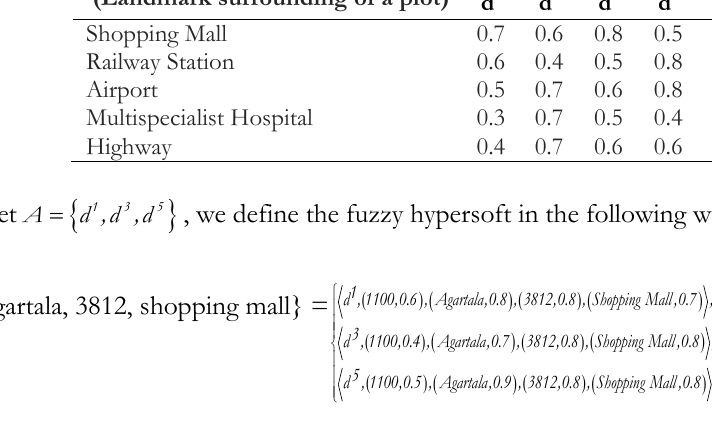
Table 4. Decision making fuzzy values for the landmark surrounding of a plot.